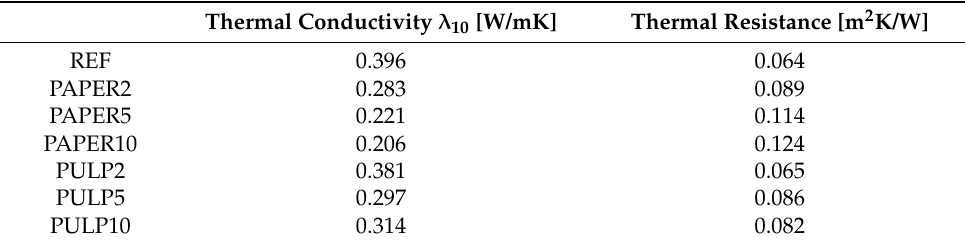
Table 3. Results of thermal tests.